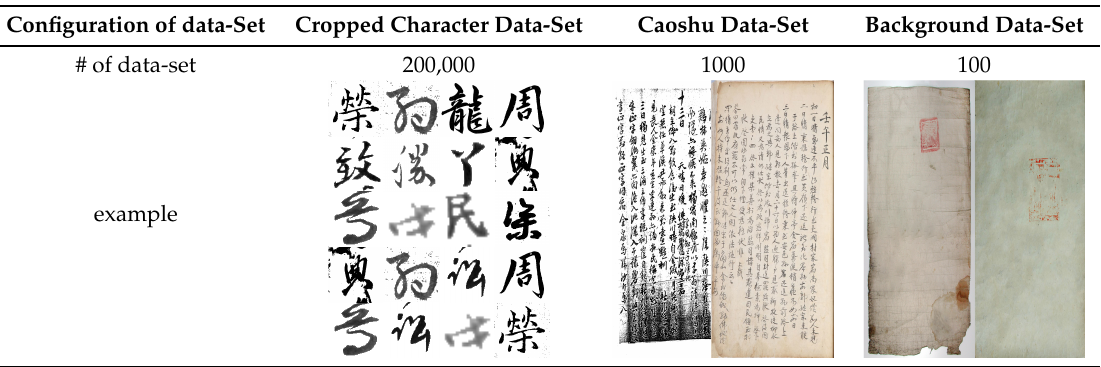
Table 1. Three types of data-set examples.